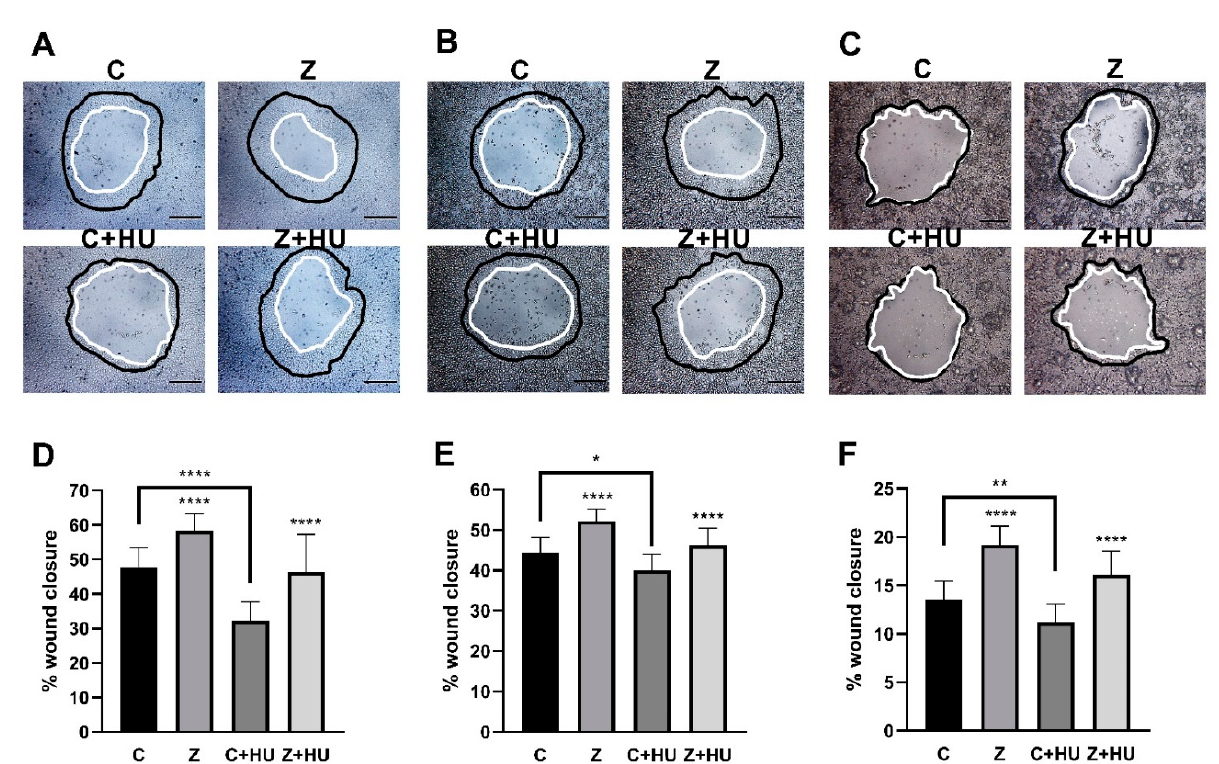
Figure 2. ZN27 stimulates rat (RGM1) and human (AGS and NCI-N87) gastric epithelial cell monolayer wound closure. ( A – C ) Typical wound images for RGM1, AGS, and NCI-N87 cells, respectively, treated with DMSO, ZN27 (10 nM), DMSO + Hydroxyurea (HU, 5 mM), or ZN27 (10 nM) + HU (5 mM) in serum-free media. ( D ) ZN27 at 10 nM accelerates circular wound closure in RGM1 cell monolayers on collagen I, even when proliferation is blocked by 5 mM hydroxyurea ( n = 12–18, pooled from 6 separate studies with similar results, **** p < 0.0001). ( E ) ZN27 at 10 nM accelerates circular wound closure in AGS cell monolayers on collagen I, even when proliferation is blocked by 5 mM hydroxyurea. ( n = 12–16, pooled from 6 separate studies with similar results, **** p < 0.0001, * p < 0.05). ( F ) ZN27 at 10 nM accelerates circular wound closure in NCI-N87 cell monolayers on collagen I, even when proliferation is blocked by 5 mM hydroxyurea. ( n = 16–18, pooled from 6 separate studies with similar results, **** p < 0.0001, ** p < 0.01). The presence of 5 mM hydroxyurea prevented proliferation-related wound closure and, therefore, reduced overall wound closure in both cell lines. Black represents the circumference of the 0-h wounds; white represents the circumference of the wounds 24 h later. Vehicle control–DMSO (C), ZN27 (Z), hydroxuyurea (HU). All images were captured at 10x magnification. Scale bars, 200 µm.